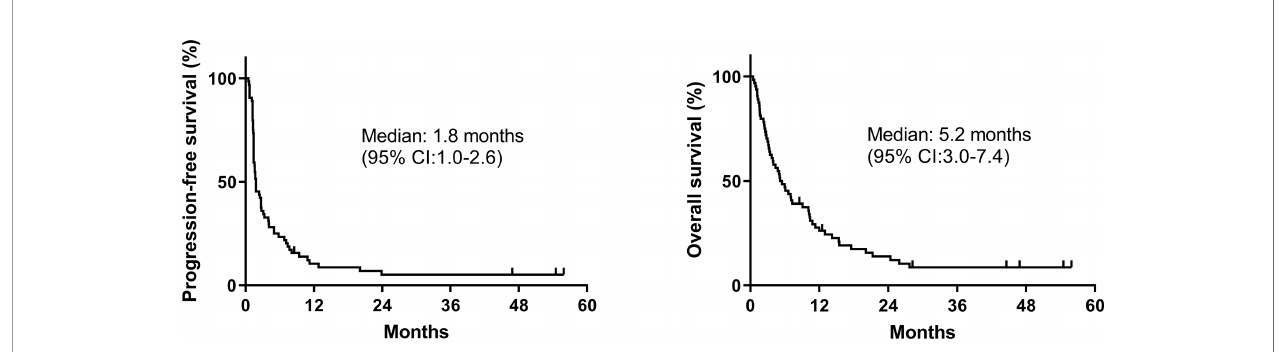
FIGURE 1 | Kaplan – Meier survival curves of progression-free survival and overall survival of the entire cohort.